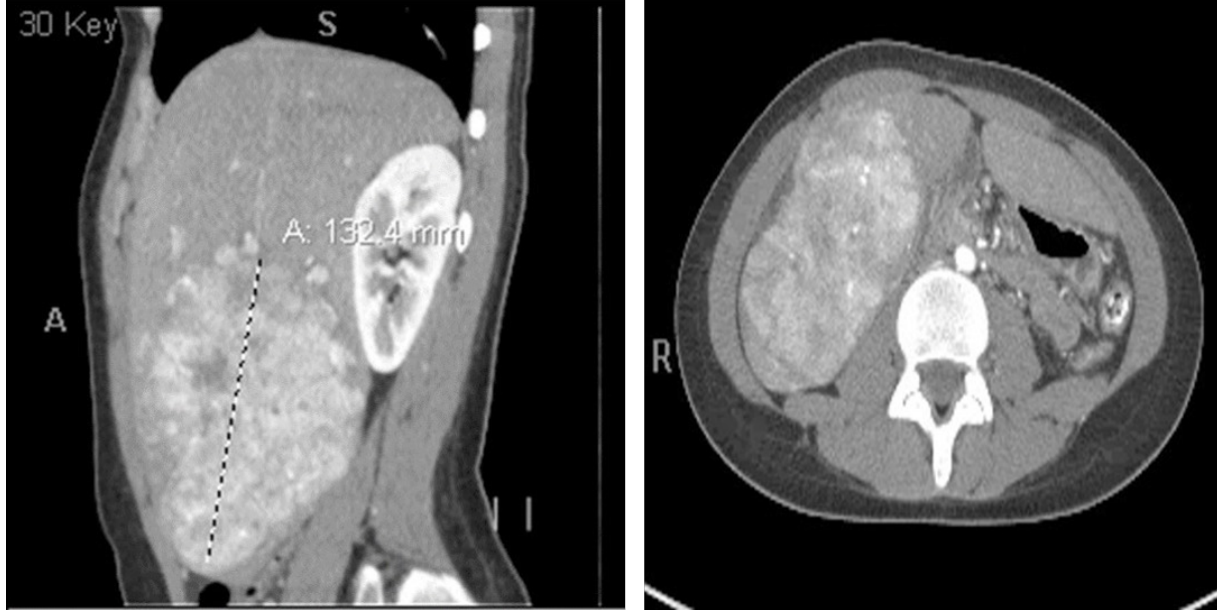
Figure 1: CT abdomen with IV contrast shows heterogeneous appearing, vascular nodular right mass of around 13